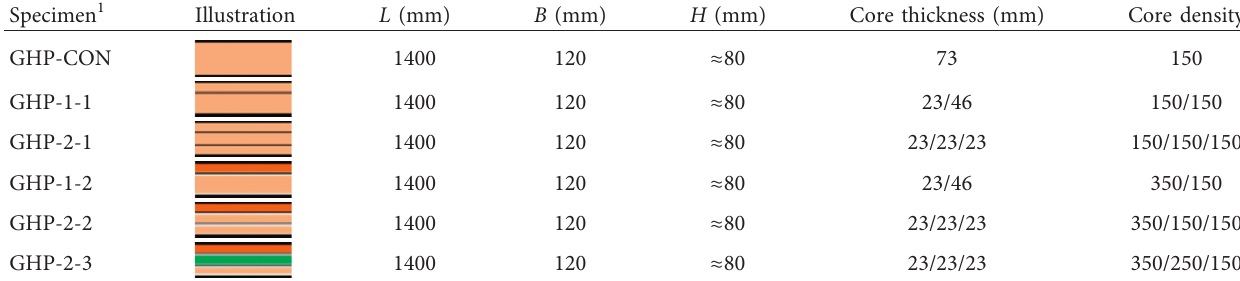
Table 2: Summary of the test matrix and parameters of GHP specimens.